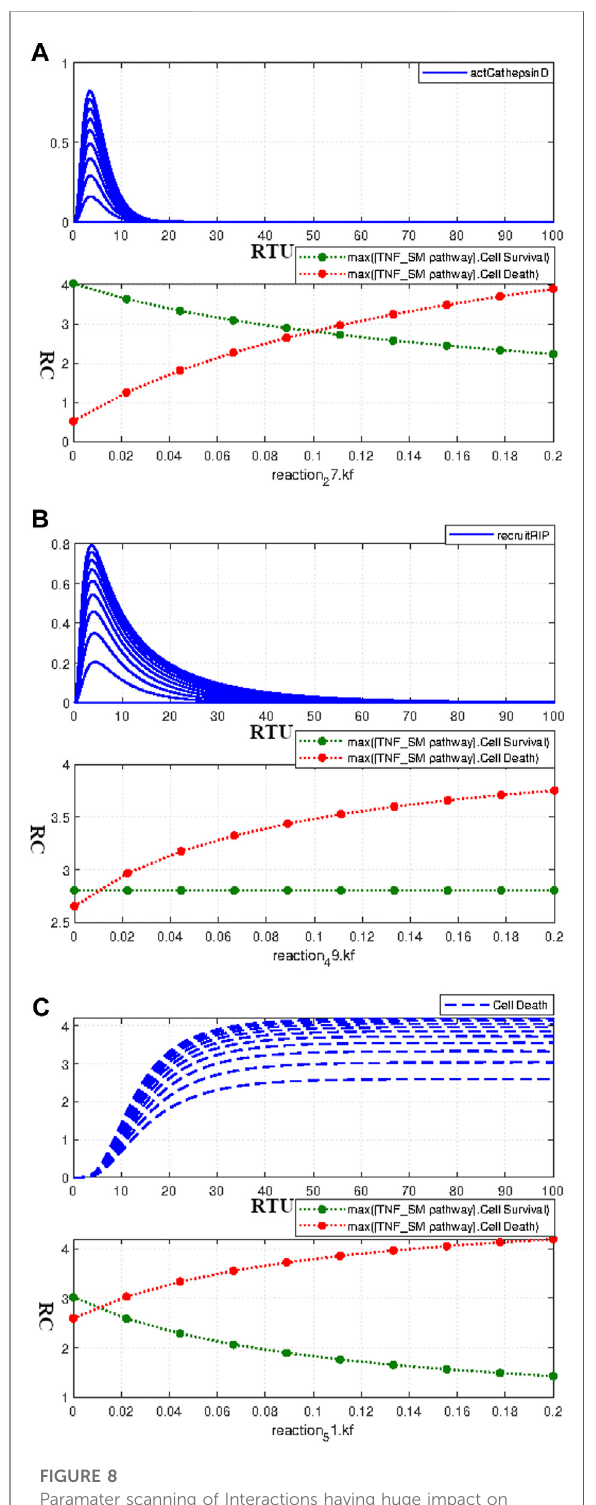
FIGURE 8 Paramater scanning of Interactions having huge impact on the Neuronal Survival and Apoptosis- (A) Paramater scanning of Interaction 27 (Eq. 17) representing Cathepsin D activation. (B) Paramater scanning for Interaction 49 (Eq. 18) representing RIP recruitment. (C) Paramater scanning for Interaction 51 (Eq. 19) representing ERK-mediated Cell Death. The increasing parameter